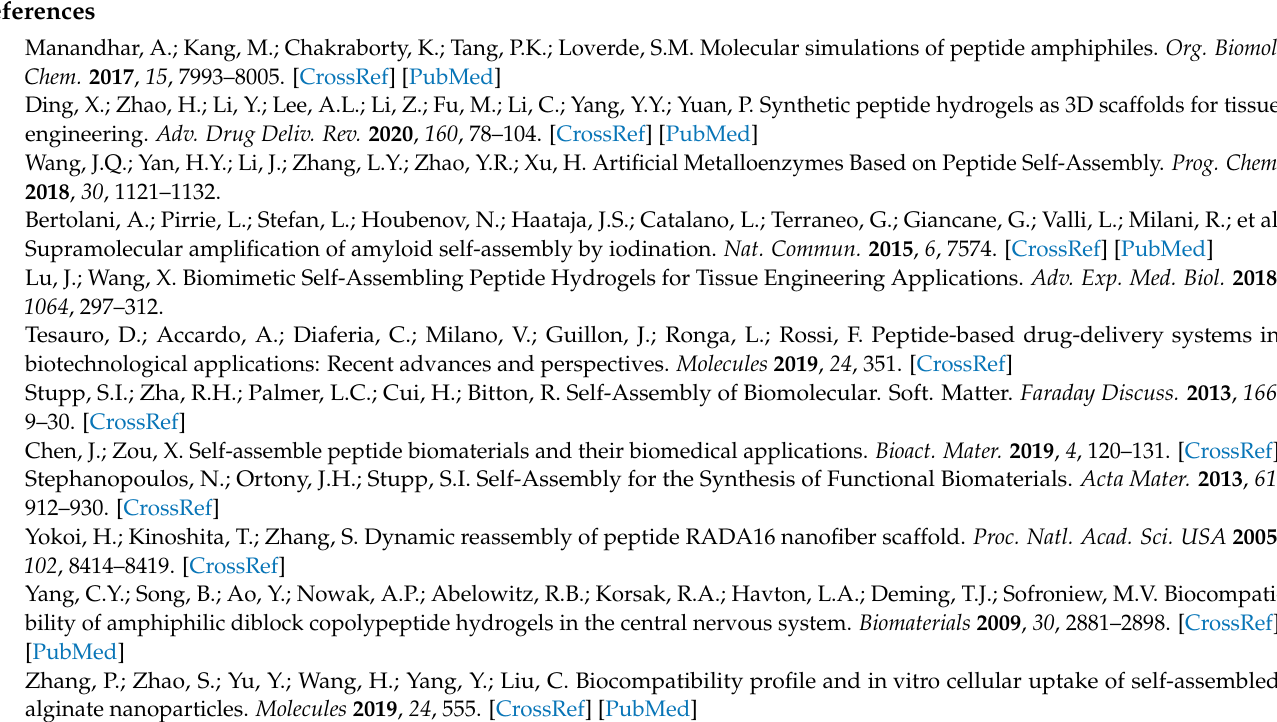
Figure S6: 13 C NMR spectrum of PFB-IKVAV in DMSO- d 6